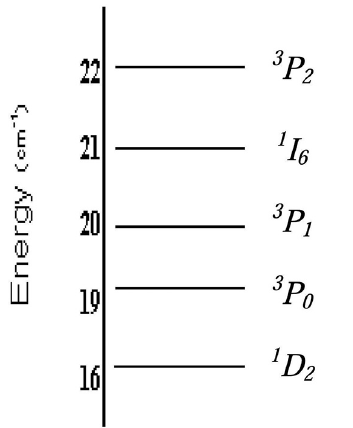
Figure 6: Energy level diagram of Pr 3+ in Li from absorption